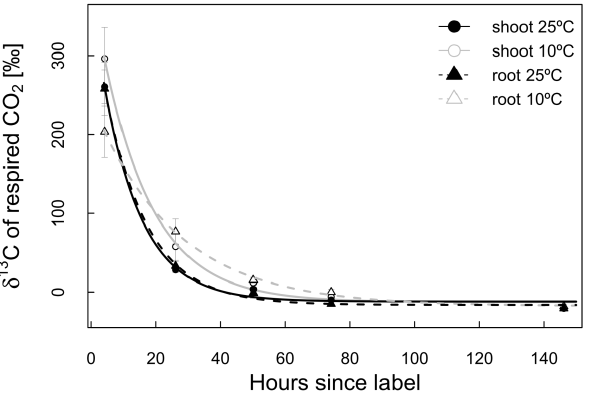
Figure 2: Exponential decay of the δ 13 C respiration signal in shoot and root. The data shown 2 Fig. 2. Exponential decay of the δ 13 C respiration signal in shoot are means ± standard error ( n = 3). Lines are fitted exponential decay functions (using f(t) = 3 and root. The data shown are means ± standard error ( n = 3). Lines y 0 + a e -λt ). 4 are fitted exponential decay functions (using f (t) = y 0 + ae − λt ).